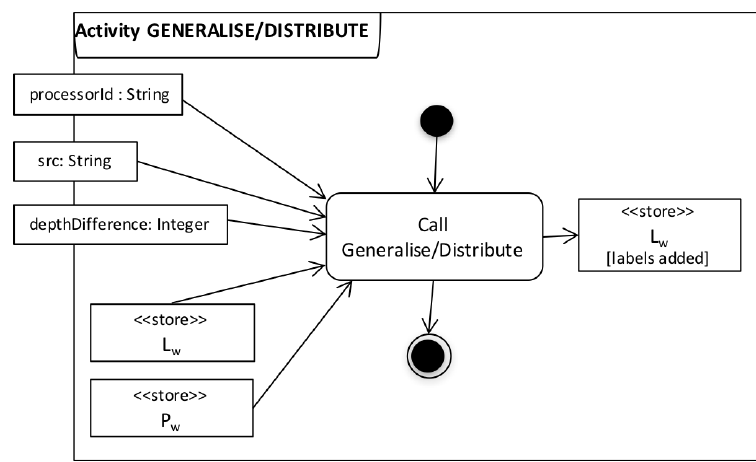
Figure 11. Distribute and Generalise Operator